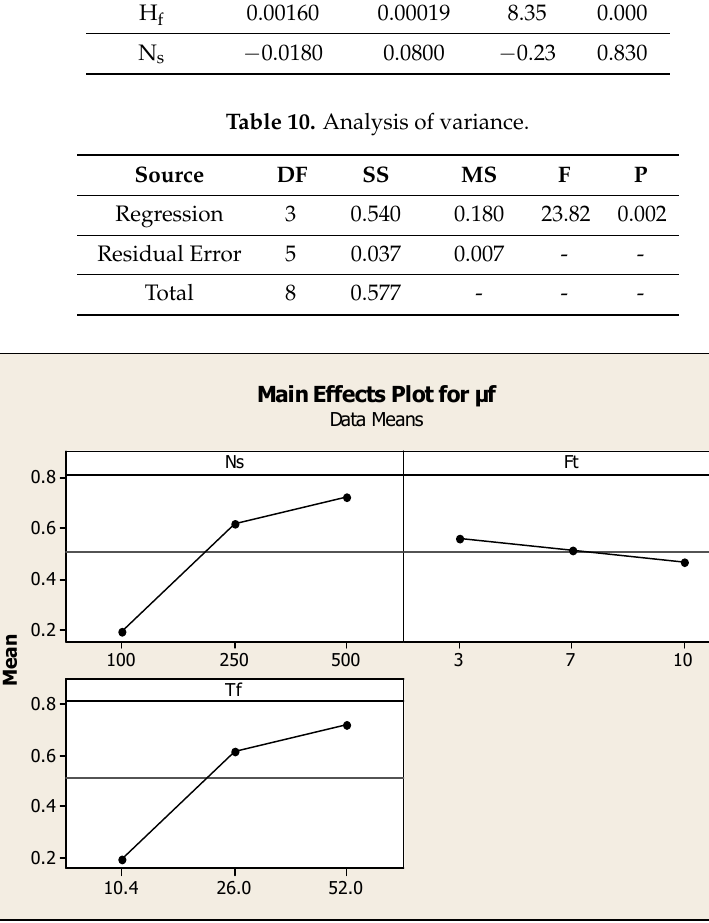
Figure 7. Effect of speed, torque, and friction time on µ f